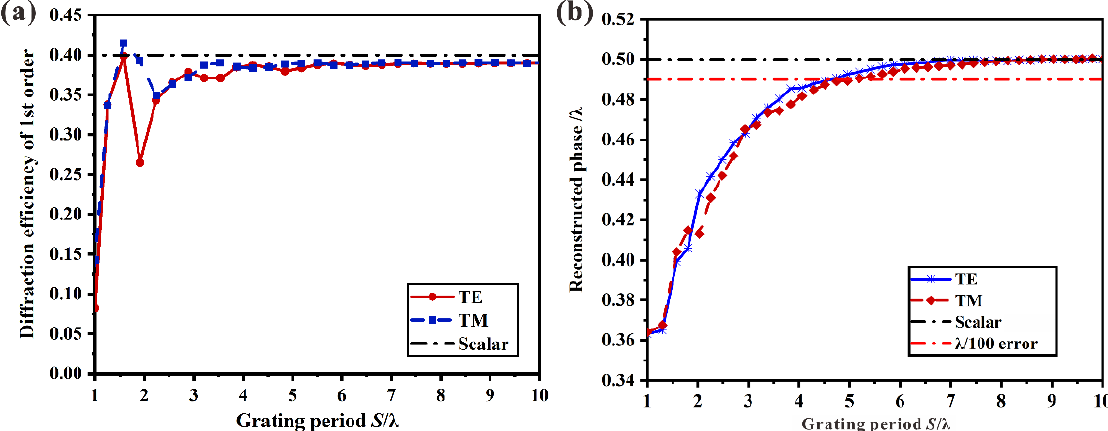
Figure 4. Comparison of illumination in transverse electric (TE) and transverse magnetic (TM) polarized light for ( a ) diffraction efficiency and ( b ) phase generated by transmission grating with a variable period.